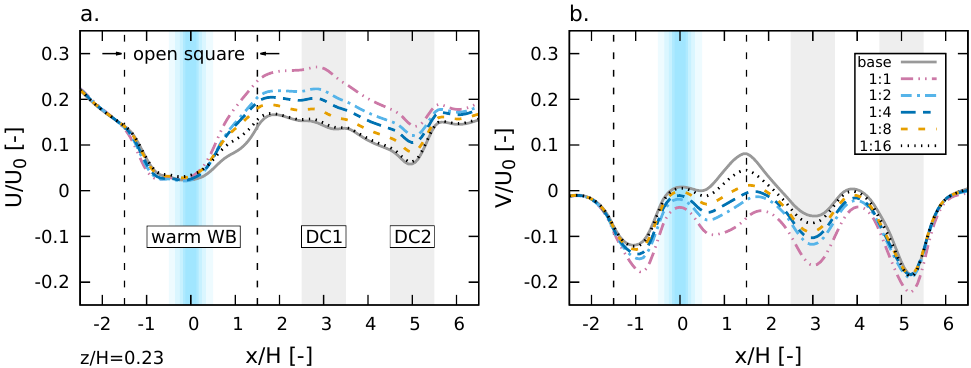
Figure 8. Profiles of ( a ) normalised streamwise ( U / U 0 ) and ( b ) normalised spanwise ( V / U 0 ) velocity over a horizontal line in the middle of the street canyon ( y / H = 1) at pedestrian level ( z / H = 0.23) for the warm water body cases ( ∆ T = + 2 K) and different water body sizes. The shaded areas denote the position of the water body (blue) and the downwind canyons DC1 and DC2 (grey). The location of the open square is shown with the vertical dotted lines.